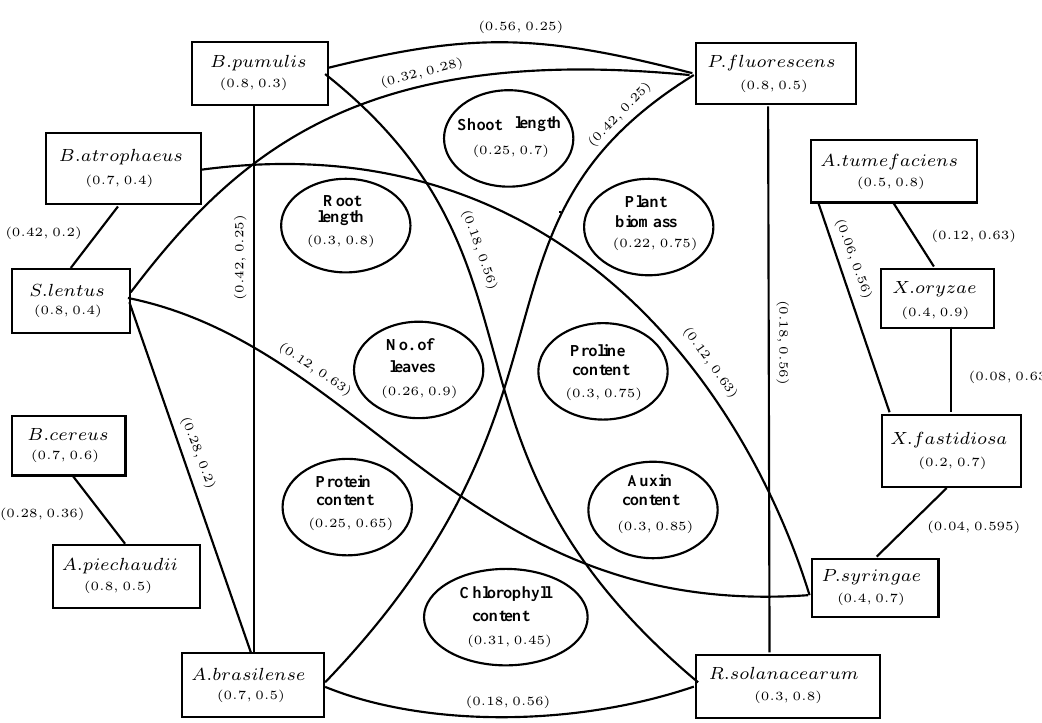
Figure 19. Pythagorean Fuzzy Competition Figure 5.3: Pythagorean Fuzzy Competition Graph